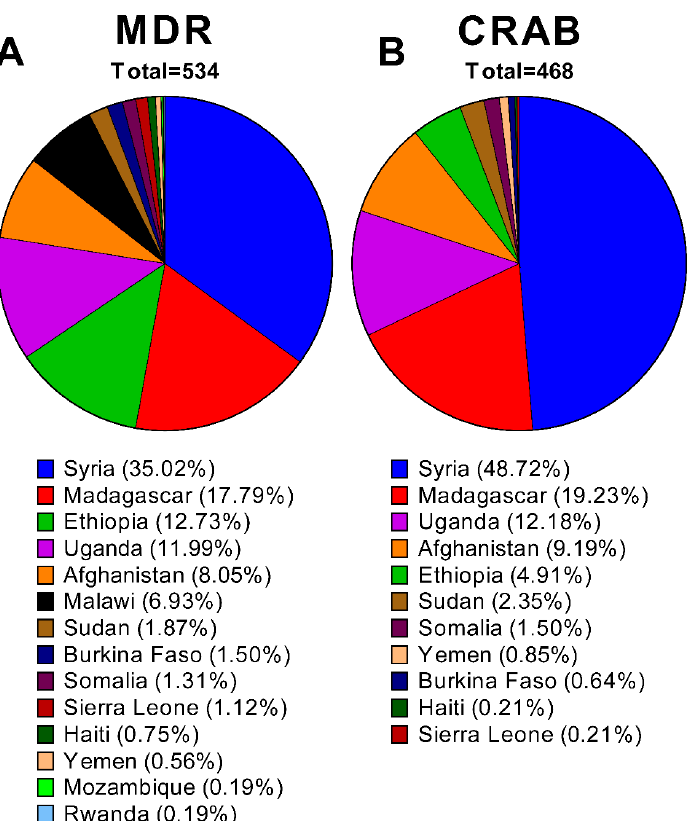
Figure 4. Pie charts of the contributions of the different LICs to the total number of MDR ( A ) and the CRAB ( B ) strains included in the reports analyzed in the current review. The percentages were calculated by dividing the number of strains reported in each category in the respective studies divided by the total number of MDR ( n = 534) and CRAB ( n = 468) strains. The charts were generated using GraphPad Prism v9 (GraphPad Software, San Diego, CA, USA).